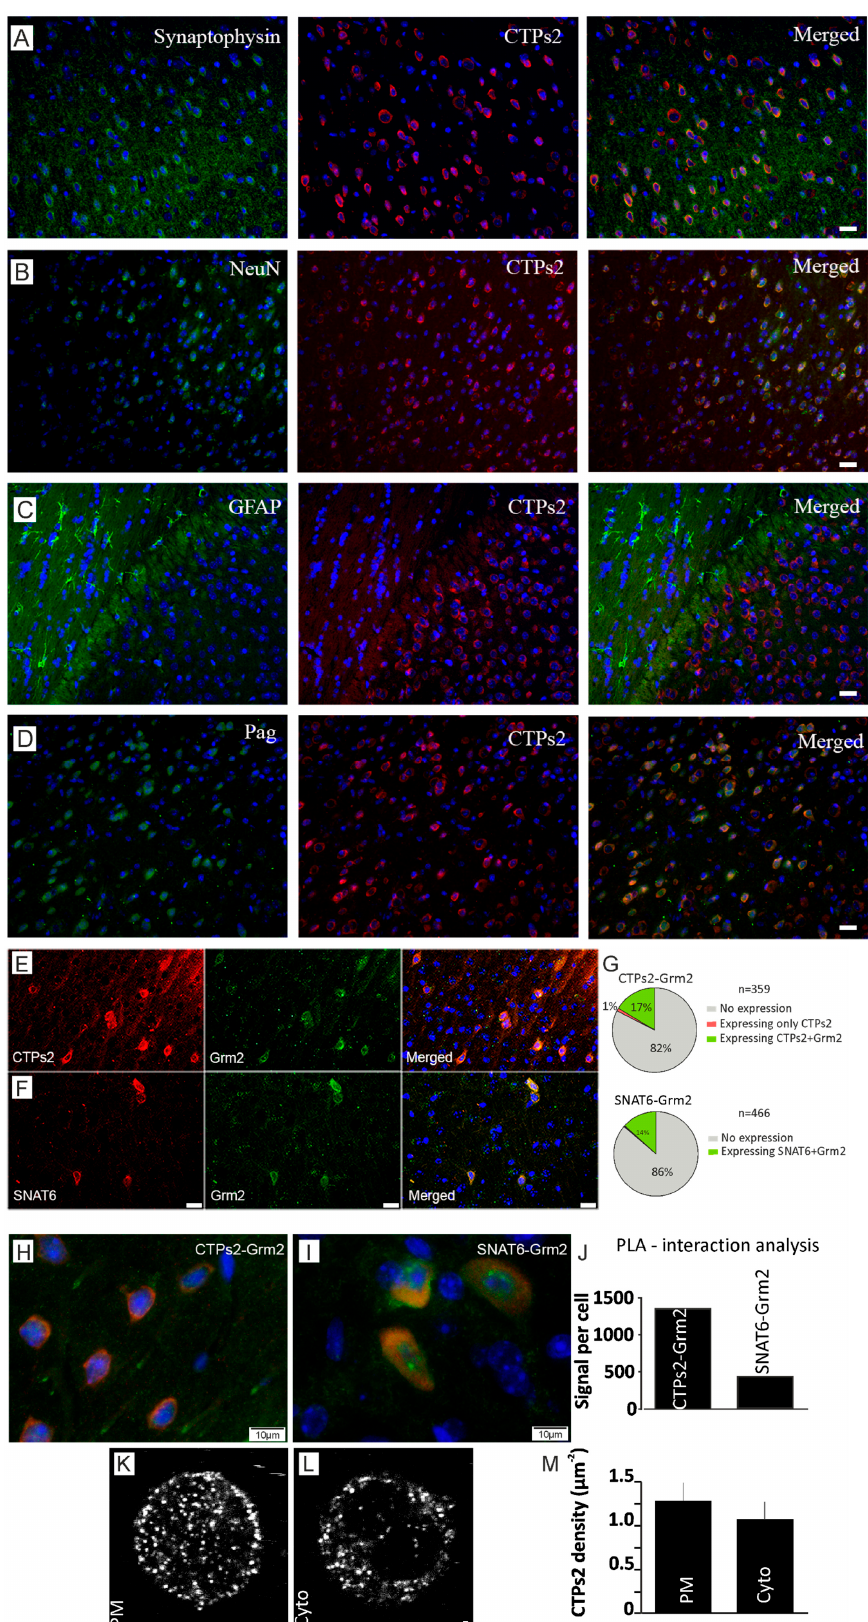
Figure 3. Downstream role of Pag, CTPs2, Grm2 and NeuN in glutamate-glutamine cycle. ( A ) This horizontal panel shows staining with synaptophysin, CTPs2 and their merged image from left to right. Scale bar 10µM ( B ) Horizontal panel shows staining with NeuN, CTPs2 and their merged image from left to right. Scale bar 10µM ( C ) Horizontal panel shows staining with GFAP, CTPs2 and their merged image from left to right. Scale bar 10µM ( D ) Horizontal panel shows staining with Pag, CTPs2 and their merged image from left to right. All micrographs have nucleus stained in blue with DAPI. The first vertical column exhibits different markers in green (Alexa fluor 488), whereas the middle column illustrates CTPs2 stain- ing in red (Alexa fluor 594) in all four micrographs. The last column shows merged images of first two columns. Scale bar 10µM ( E ) Horizontal panel shows staining with CTPs2, Grm2 and their merged image from left to right. ( F ) Horizontal panel shows staining with SNAT6, Grm2 and their merged image from left to right. All micrographs have nucleus stained in blue with DAPI. The first vertical column exhibits CTPs2 (top) and SNAT6 (bottom) in red (Alexa fluor 594), whereas the middle column illustrates Grm2 staining in green (Alexa fluor 488) in both micrographs. The last column shows merged images of first two columns. Scale bar 10µM for E and F ( G ) Pie diagrams to illustrate that the protein pairs were not found in all the cells from mouse brain tissue, but they always co-stained the cells they were detected in. For co- staining of CTPs2 and Grm2, 359 cells were manually counted to reveal no expression in 82% of cells, only CTPs2 expres- sion in 0.84% (rounded up to 1% in Figure 3) of cells, only Grm2 expression in 0% of cells and co-expression in 17% of cells. For co-staining of SNAT6 and Grm2, 466 cells were manually counted to reveal no expression in 86% of cells, only SNAT6 expression in 0.43% (rounded up to 0% in Figure 3) of cells, only Grm2 expression in 0% of cells and co-expression in 14% of cells. ( H ) Double immune-staining with CTPs2 in red (Alexa fluor 594), Grm2 in green (Alexa fluor 488) and nucleus in blue (DAPI). ( I ) Double immune-staining with SNAT6 in red (Alexa fluor 594), Grm2 in green (Alexa fluor 488) and nucleus in blue (DAPI). ( J ) Proximity ligation analysis (PLA) shows 1343.33 signals per cell for protein pair CTPs2 and Grm2 and 428.5 for SNAT6 and Grm2. The experiments were repeated multiple times in the same manner. ( K − L ) Im- munostained images of CTPs2 at the plasma membrane (PM) and cytosol (cyto) of the cell. Scale bar 1 µM ( M ) Density of CTPs2 clusters was assessed using plugin called “find maxima” described in the methods. These experiments were re- peated twice with at least 13 cells per time.